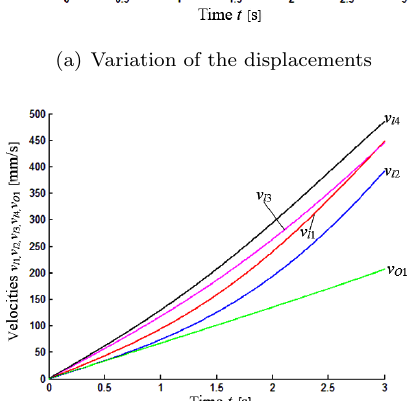
Figure 8: The kinematics and dynamics results of the